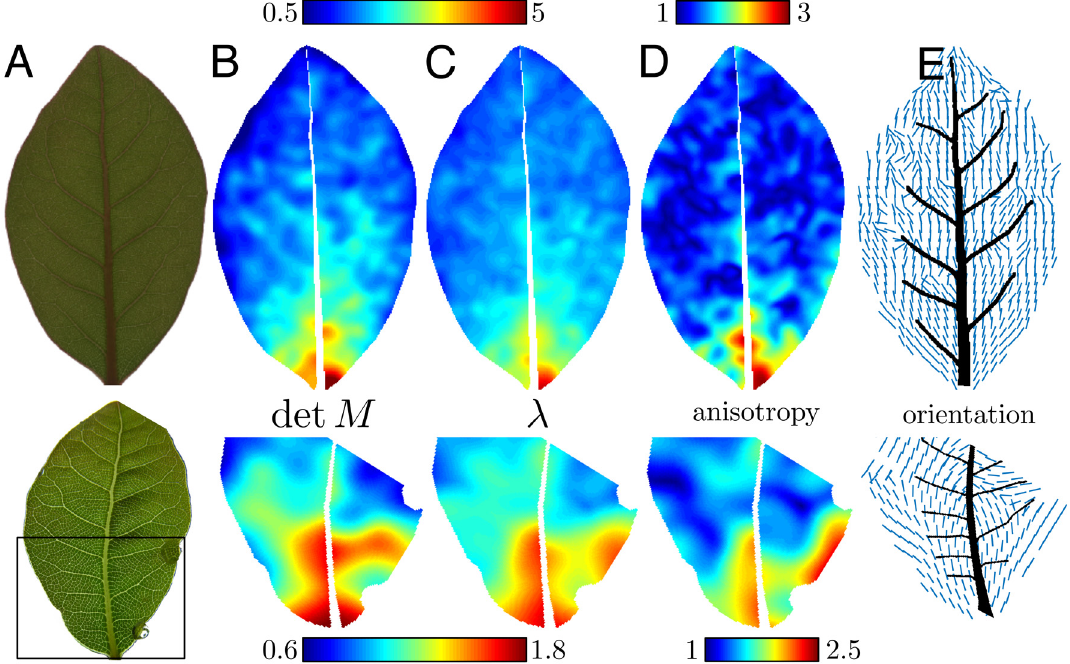
Fig 5. Quantifying the effect of stretching on a leaf. Various scalar quantities defined from the averaged texture tensor M , for bay leaves that grew free of external stress (top row), or stretched (bottom row, arrows indicate the force direction). (B,C) The determinant det M , which quantifies the size of an areole, and the maximum eigenvalue λ of M , which quantifies the greater dimension of an areole. These two quantities are normalized by their average value for each leaf. Note the larger areoles at the base of the non-stretched leaf, and in the stretched region of the stretched leaf. λ attains its maximum on the edge of the leaf, while the determinant is maximal in the interior. (D,E) The anisotropy and orientation of the texture tensor (or of the corresponding ellipse); larger values of anisotropy imply elongated areoles. The orientation is noisy in regions where the texture tensor is